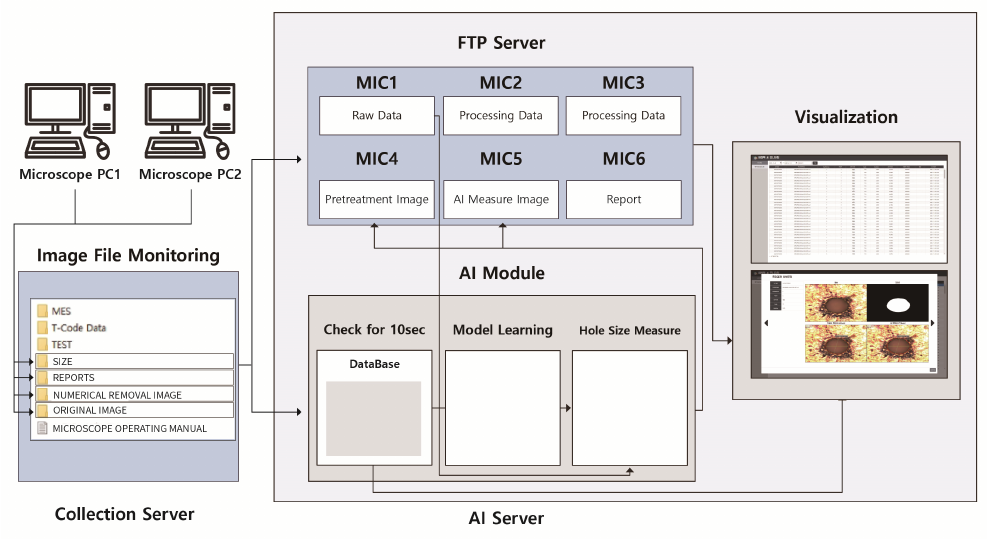
Figure 6. The structure of our inspection system when using the AI